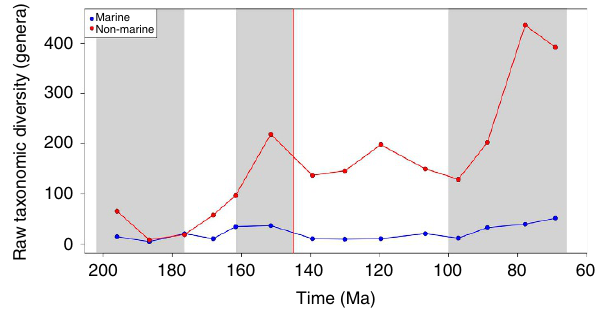
Figure 1 | Raw taxonomic diversity. Taxonomic diversity estimate (TDE) for marine and non-marine Jurassic and Cretaceous tetrapods, grouped into approximately equal 10 million year time